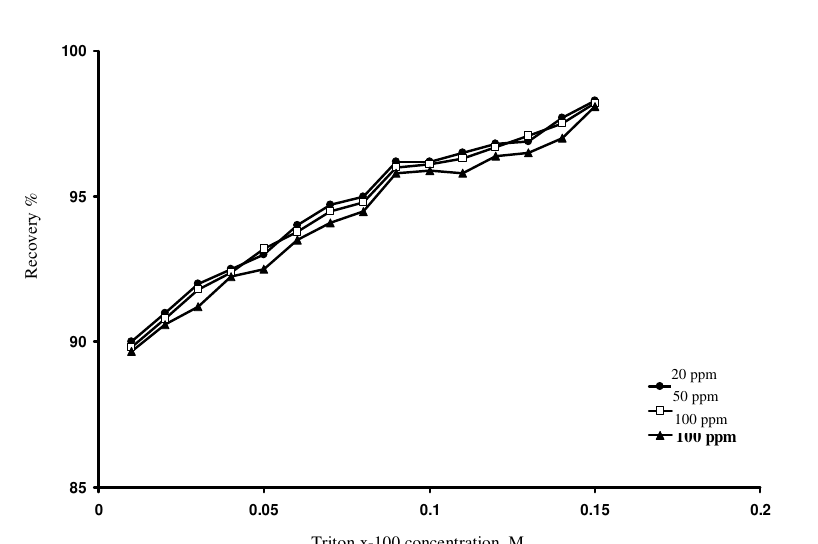
Figure 3. Effect of triton x-100 on removal of direct yellow 12 (Conditions: 50 mL of solution containing different concentration of dye (20, 50 and 100 ppm), 0.4 M of NaCl and pH 4, equilibration temp 75 o C and equilibration time 20 min, centrifuge time 10 min and centrifuge rates 3500